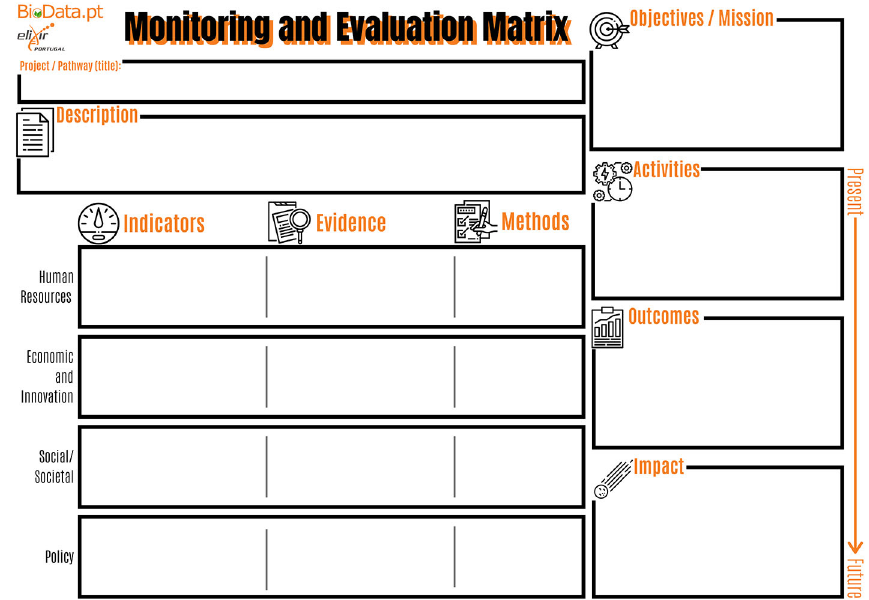
Figure 2. BioData.pt Monitoring and Evaluation Matrix. This matrix, internally developed during the BioData.pt project, was used to understand and document project working groups in terms of activities, outcomes and